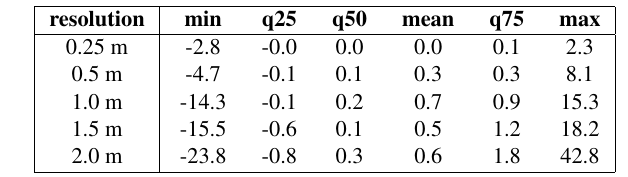
Table 3: Summary of relative errors of the volume calculation for the new method. [%]